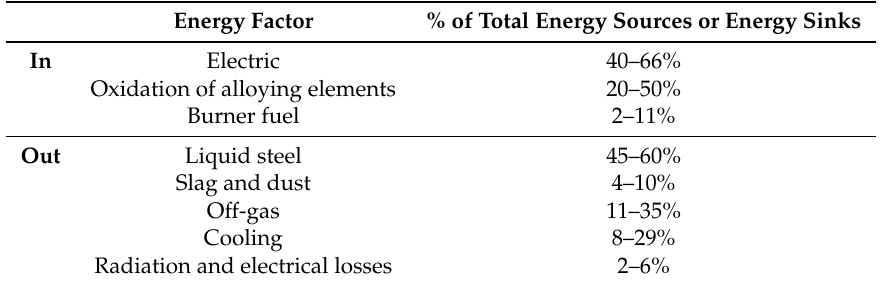
Table 1. Synthesized values of energy sources and energy sinks reported in